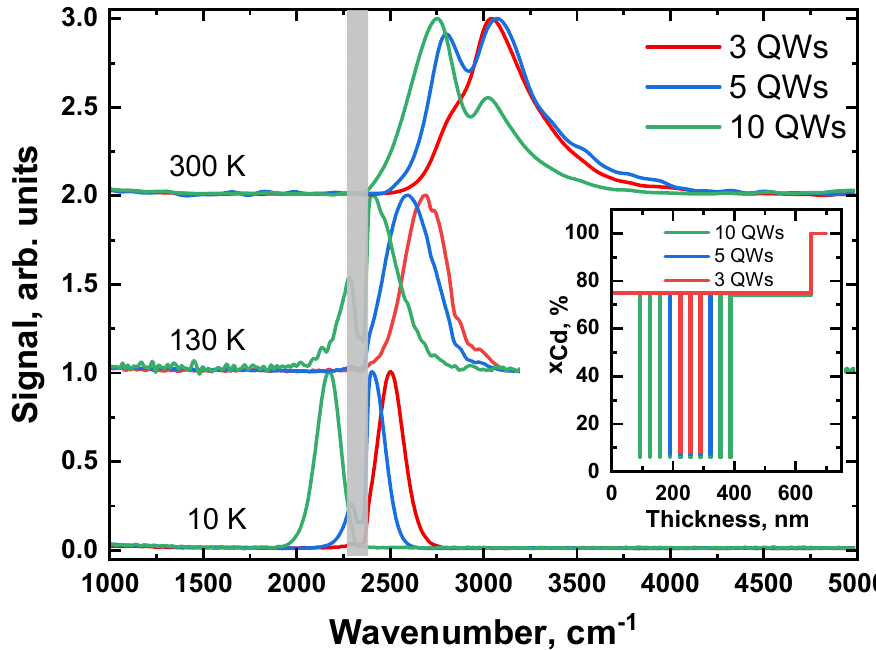
Figure 1. Photoluminescence spectra of Hg 1 − x Cd x Te quantum well (QW) structures with different number of QWs at different temperatures under 808 nm diode laser excitation; grey box covers the region of high atmospheric absorption at ≅ 2330 cm − 1 . The inset shows the growth scheme of the samples, zero correspond to the end of 10- μ m CdTe buffer.